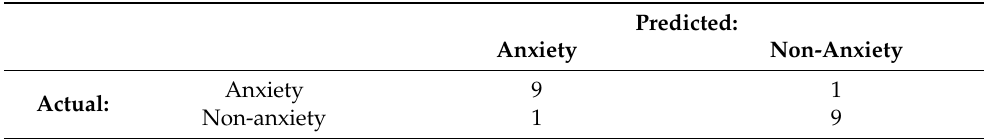
Table 12. Confusion matrix of RFC for the anxiety classifier using activity tracking and minimal GAI assessment features.